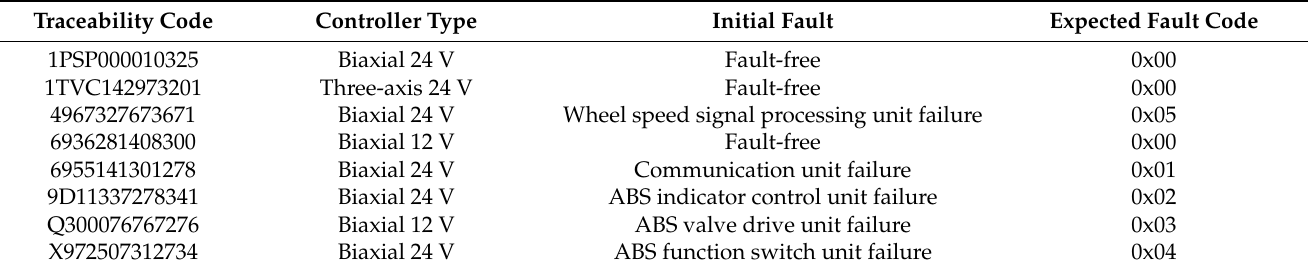
Table 5. Record of initial faults of controllers.